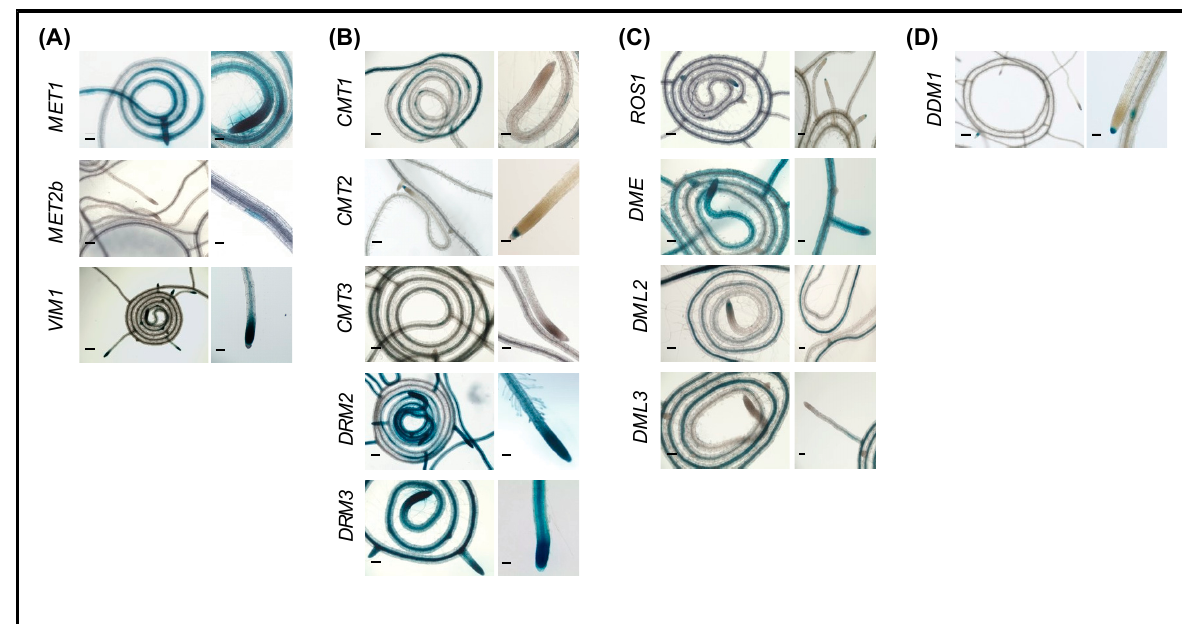
Figure 1. Promoter activity of DNA methylation and demethylation-related genes in two-week-old roots. A–C: Histochemical localization of GUS activity directed by promoters of the CG methylation-related genes MET1 , MET2b , and VIM1 ( A ), the non-CG and RdDM-related methyltransferases CMT1 , CMT2 , CMT3 , DRM2 , and DRM3 ( B ), the demethylases ROS1 , DME , DML2 , and DML3 ( C ), and DDM1 ( D ). Scale bar = 5 mm.